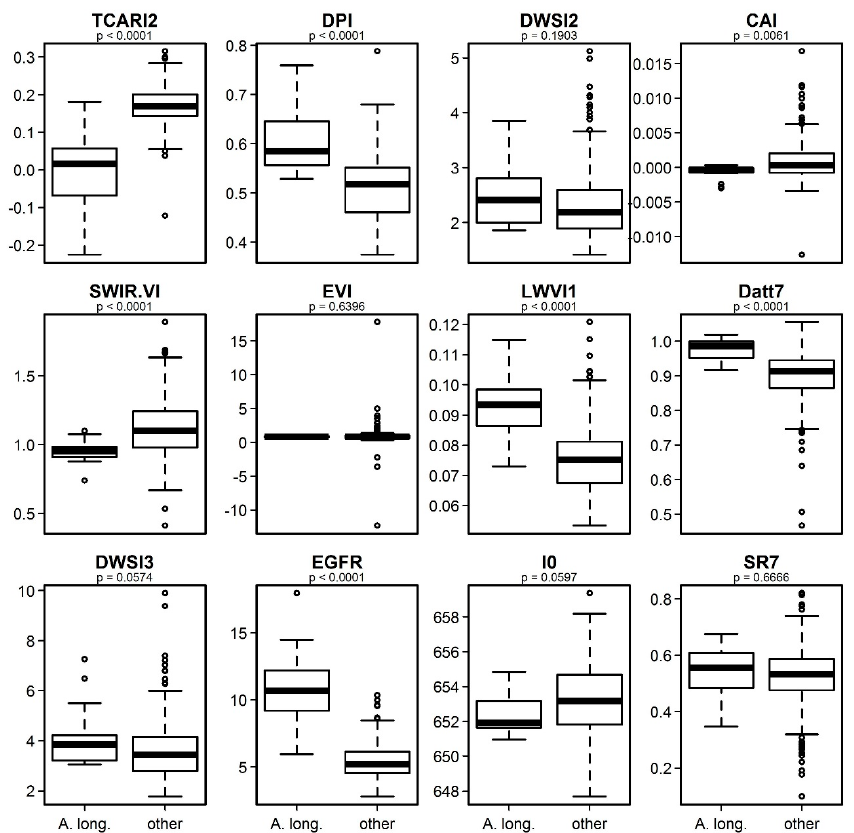
Figure A1. Boxplots of the vegetation indices used at canopy level to distinguish Acacia longifolia (“A. long.”) from other exotic and native dune species (“other”). p -values from U-Test testing for differences between the two groups are given.